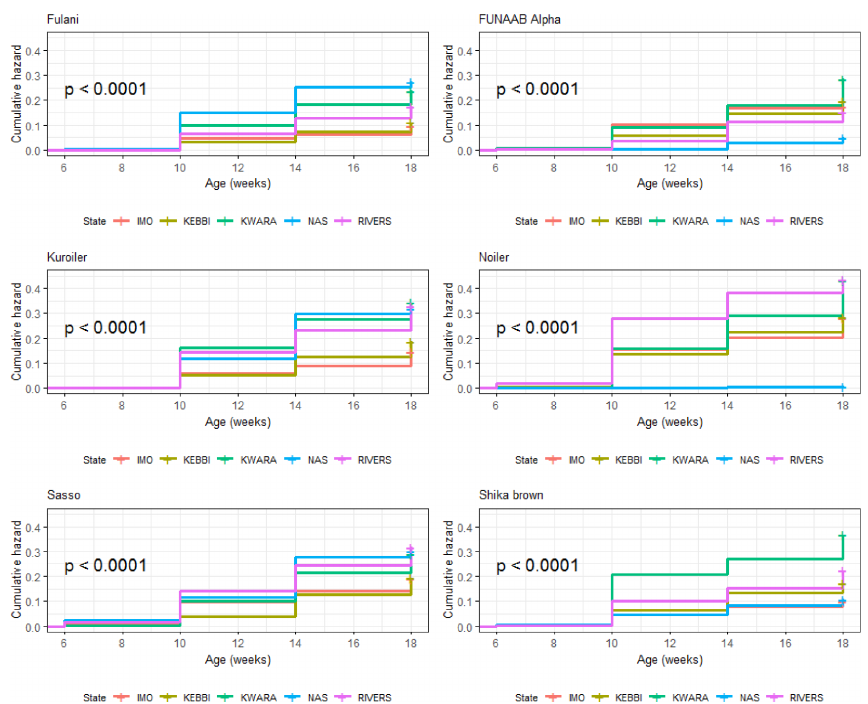
Figure 13. Breed by environment interaction on cumulative hazard of birds (breeds) during growing phase in ACGG Nigeria project zones (6–18 weeks)